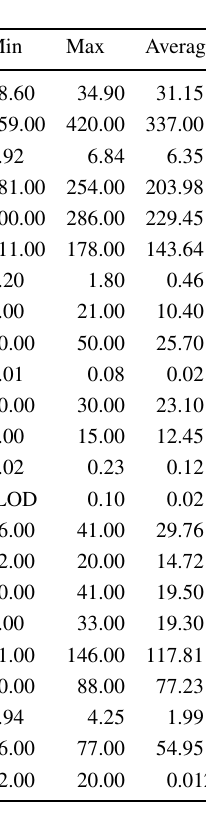
Table 4 Land subsidence inventory (TCGM 2017) Table 5 The statistics of the chemical parameters and major ions